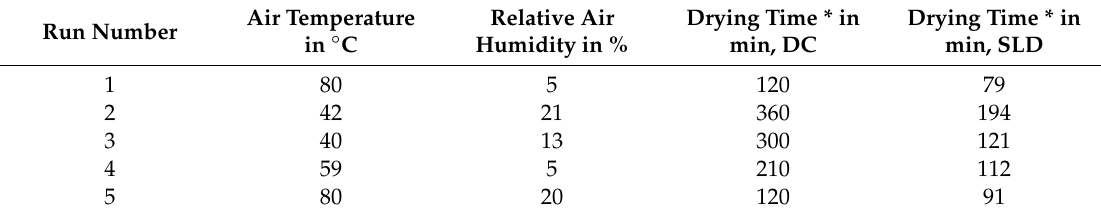
Table 1. Experimental design for runs